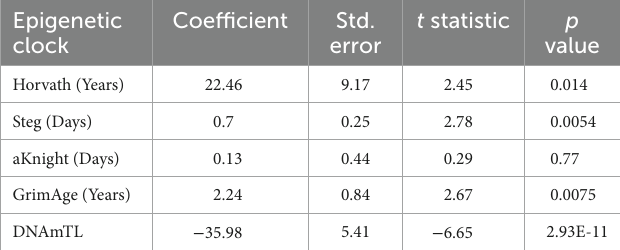
TABLE 2 Bayesian linear mixed effects model statistics for epigenetic clocks predicting total differentiation time. Epigenetic